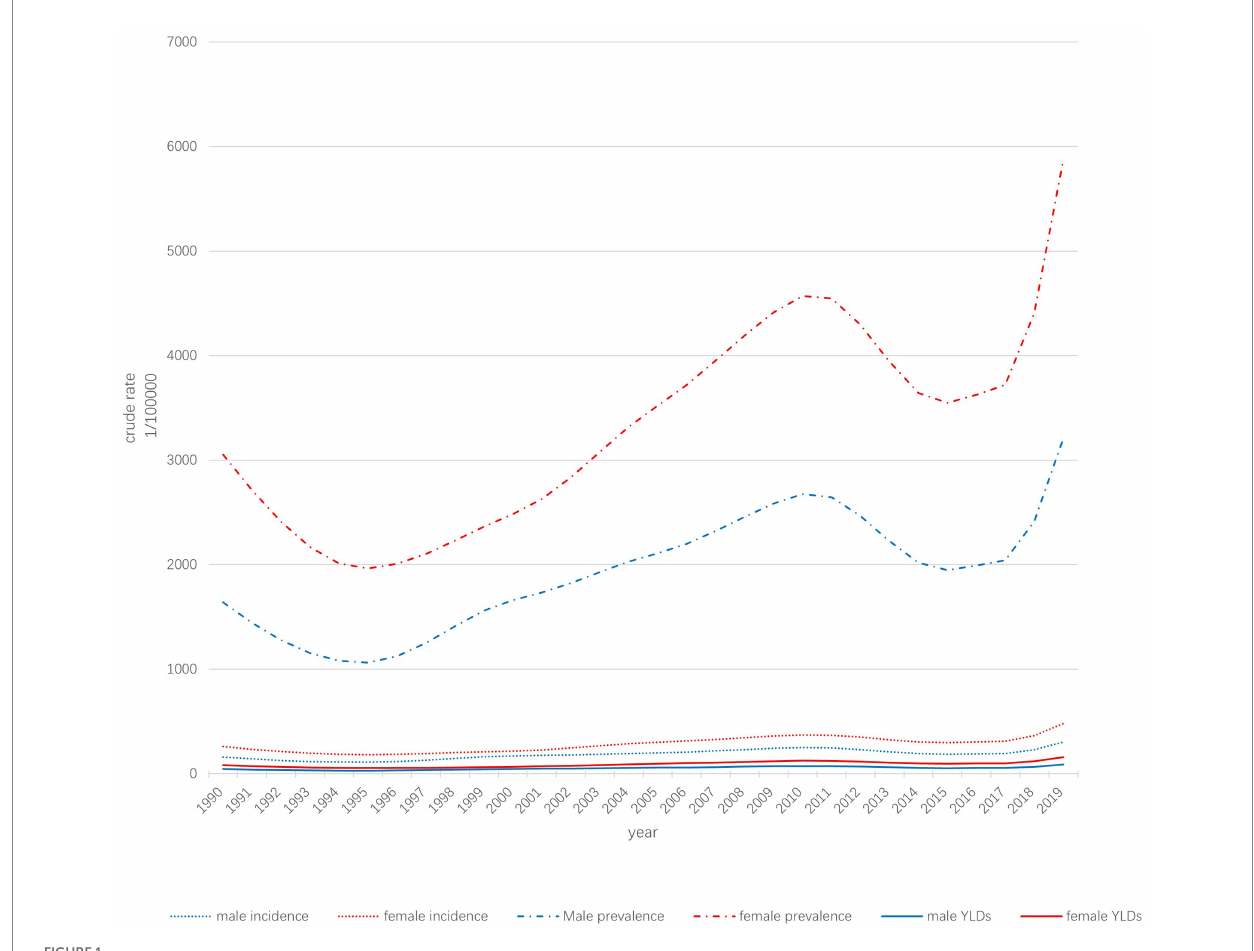
FIGURE 1 Trends in the incidence, prevalence, and YLDs of dentition loss in the Chinese